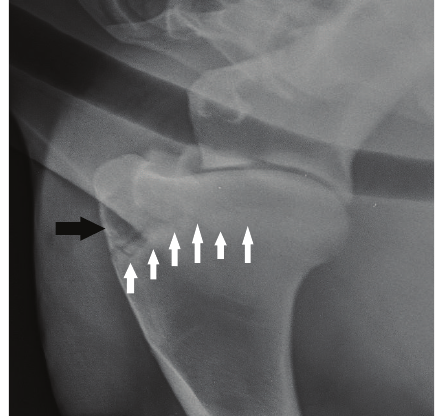
Figure 2: Lateromedial projection of the humerus: the epiphyseal growth plate of the proximal humerus (white arrows) is visible distal to the greater tubercle at the level of the radiolucent area (black arrow).